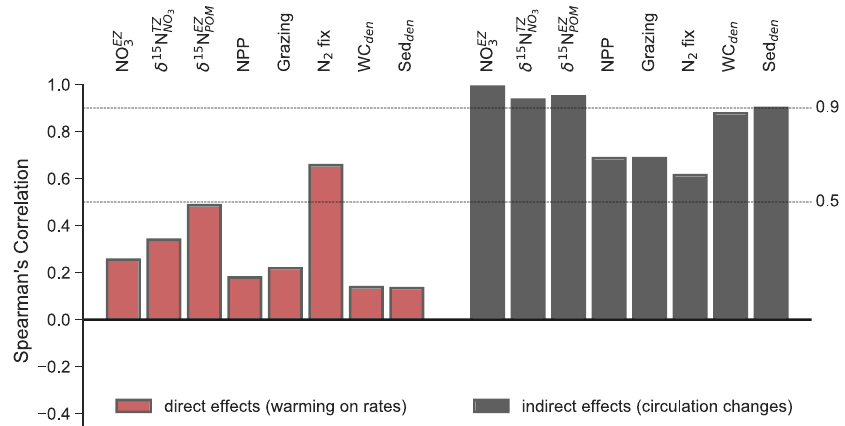
Fig. 4 Direct and indirect effects of climate change on the nitrogen cycle. How well the direct effects (warming on biogeochemical rates) and indirect effects (circulation changes, including strati fi cation) of climate change reproduce changes in the nitrogen cycle and its isotopes in the full model. Agreement is measured as a cell-to-cell comparison using Spearman ’ s rank correlation between the climate change experiment and these experiments, comparing 2D fi elds of euphotic zone nitrate ð NO EZ production (NPP), zooplankton grazing (Grazing), biological nitrogen fi xation (N 2 fi x), water column denitri fi cation (WC den ) and sedimentary denitri fi cation (Sed den ) at 2081 –